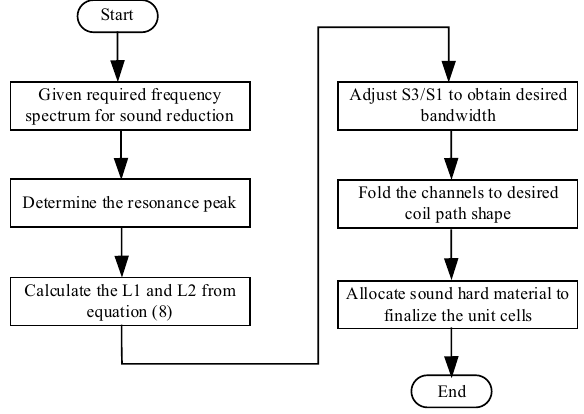
Figure 2. Design approach of labyrinth-based metasurface for noise